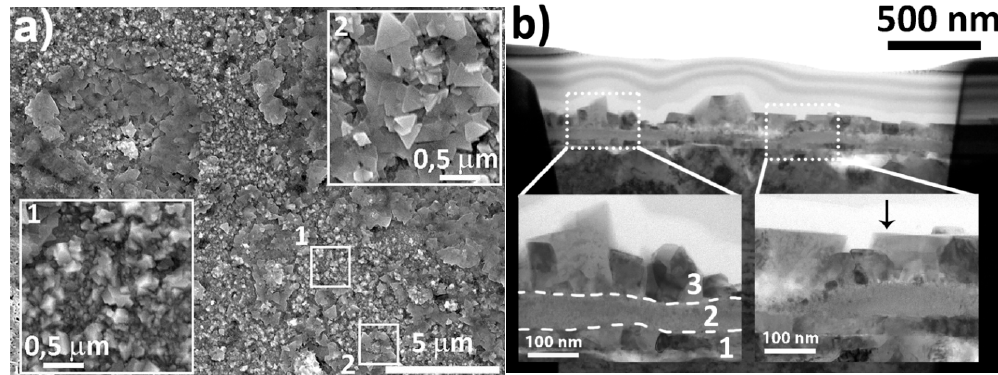
Figure 10. ( a ) SEM image of LNO-M-800 sample deposited on SS316. Insets: SEM images of marked areas at higher magnification. ( b ) Bright-field STEM images of a cross-section view of LNO-M-800 deposited on SS316. Insets: STEM images of marked areas at higher magnification.